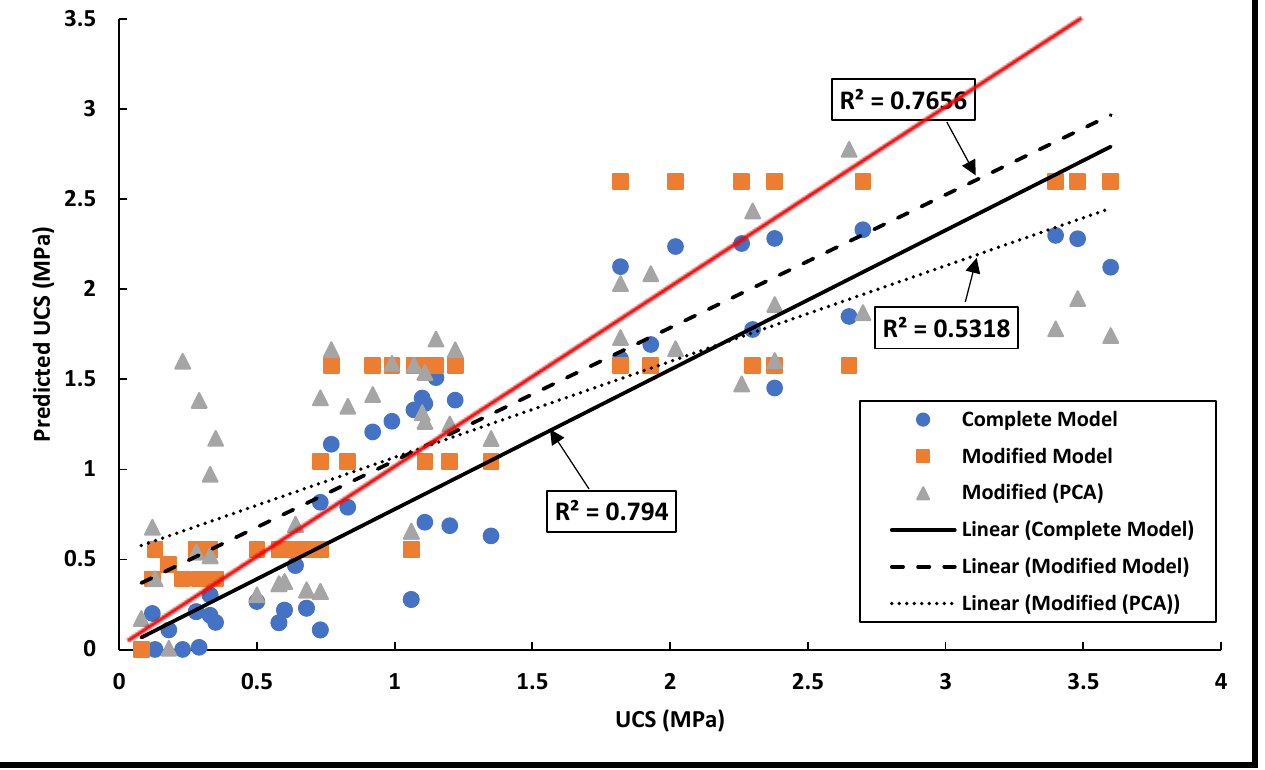
Figure 3. MLR analysis of stabilized soils (Dataset B). Table 8. PCA developed components.